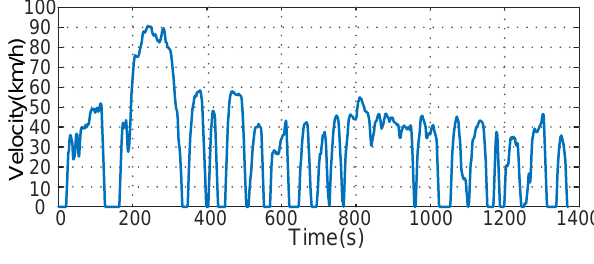
Figure 7. UDDS driving cycle.